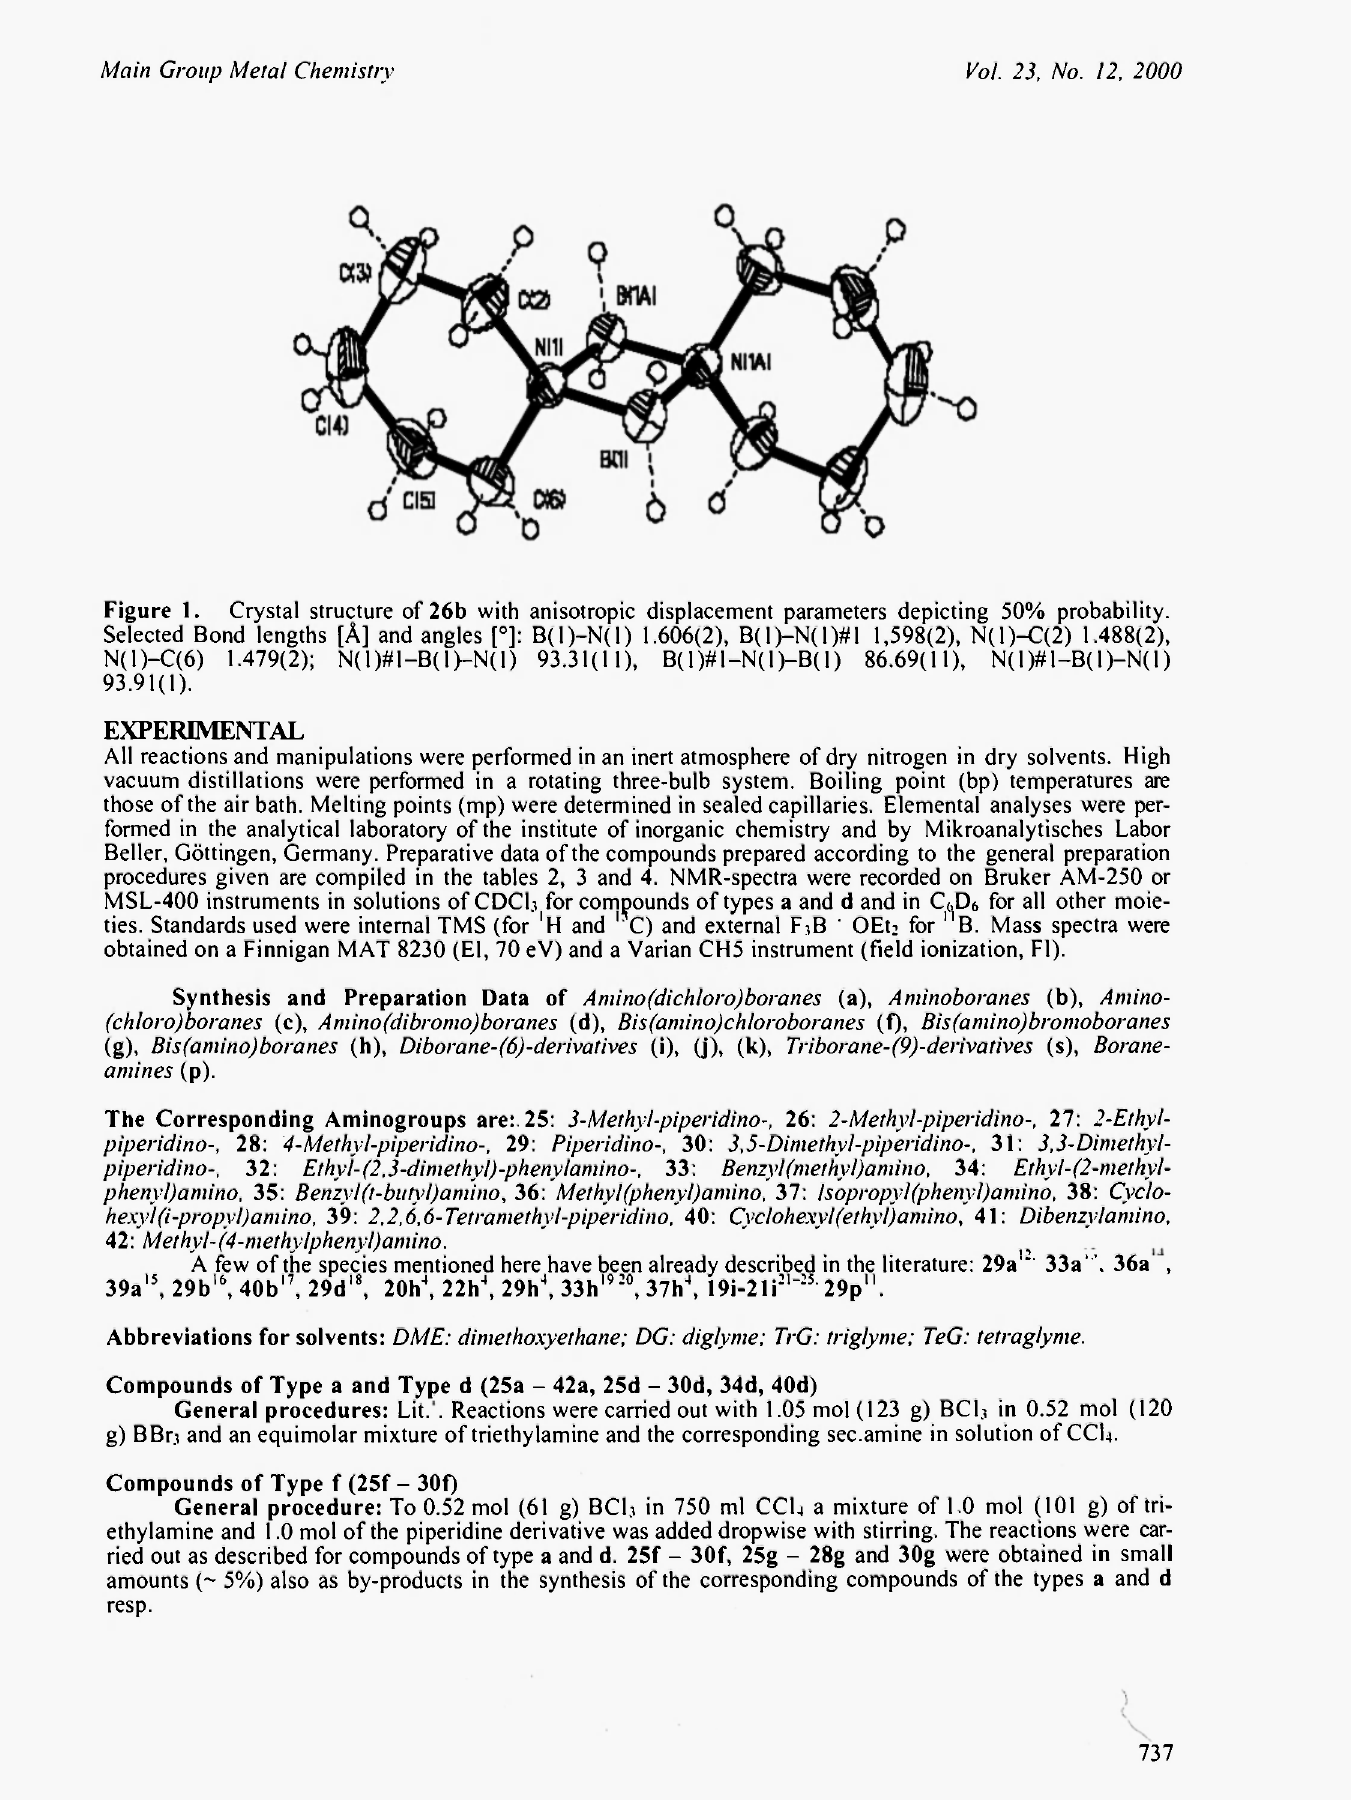
Abbreviations for solvents: DME: dimethoxyethane; DG: diglyme; TrG: triglyme; TeG: tetraglyme. Compounds of Type a and Type d (25a - 42a, 25d - 30d, 34d, 40d) General procedures: Lit. . Reactions were carried out with 1.05 mol (123 g) BCl.i in 0.52 mol (120 g) BBr.i and an equimolar mixture of triethylamine and the corresponding sec.amine in solution of